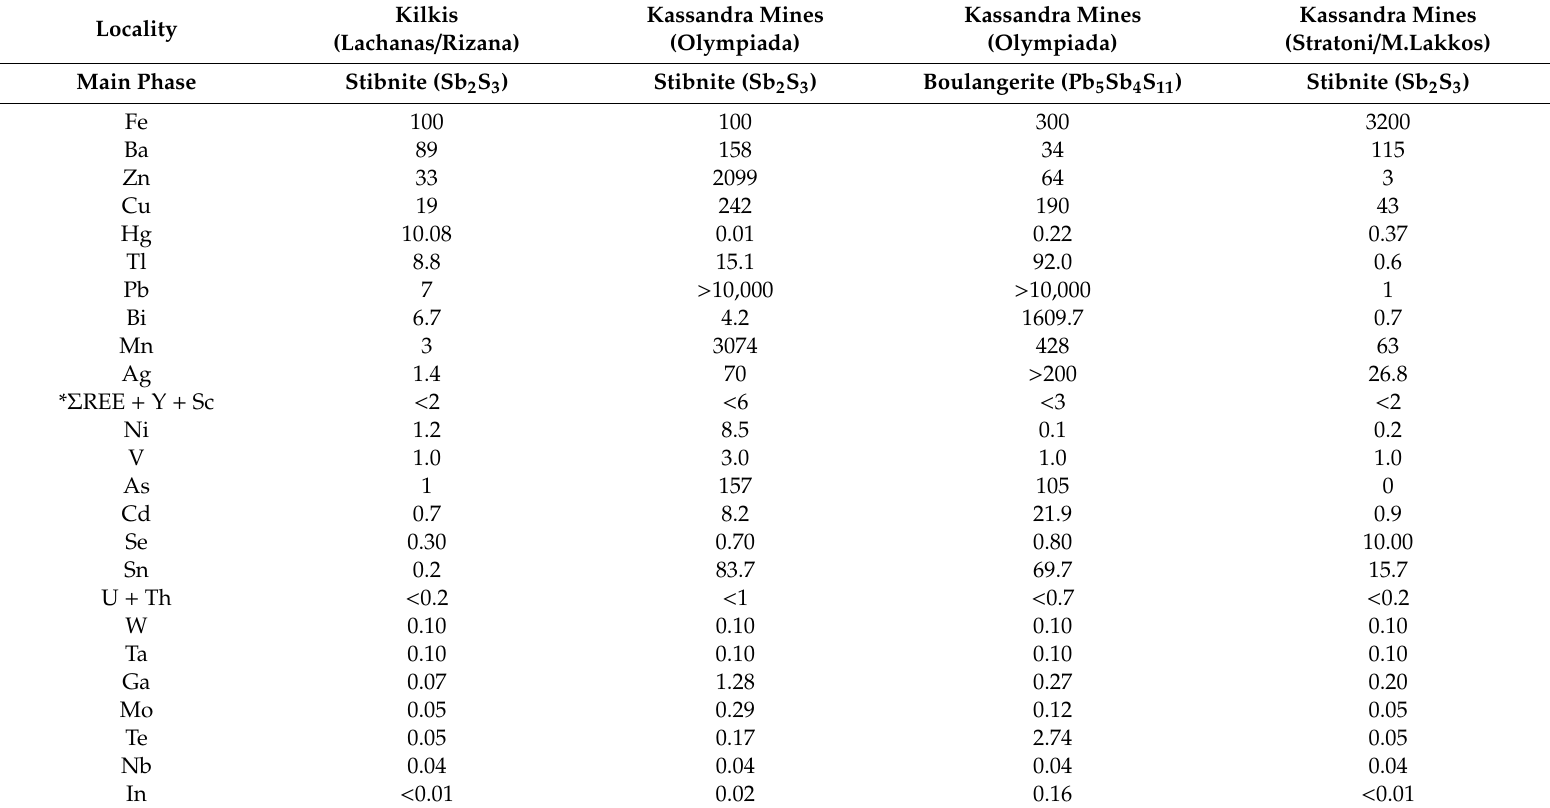
Table 3. Trace element chemical composition (ppm) of Sb minerals from Greek